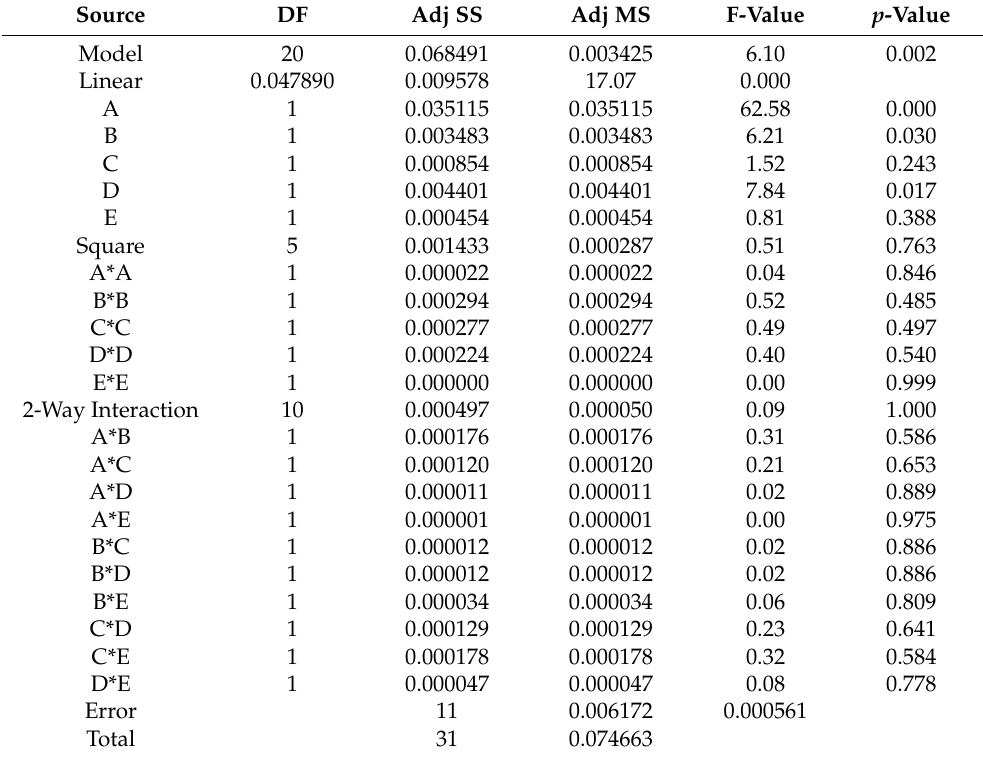
The contour plots in Figure 3 represent the correlations between numerous independent factors for biovanillin formation. These plots can be formed between any two independent variables, with the third variable’s level held constant to achieve the best results. The color variations depict the stages of vanillin production between two independent